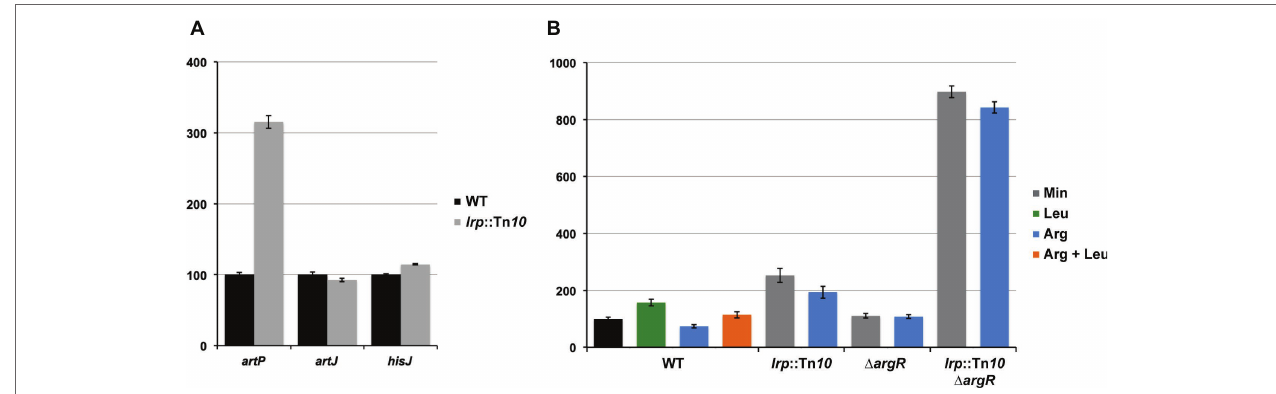
FIGURE 2 | Histogram presentation of β -galactosidase specific activities. Values are the means ± standard deviation of at least three biological replicates. (A) Specific activities measured in cell-free extracts of E. coli strain FW102 (WT) and its isogenic lrp ( lrp ::Tn 10 ) derivative bearing a single-copy lacZ reporter gene fusion under the control of the artP , artJ , or hisJ promoter/operator grown on minimal medium. 100% corresponds for each fusion construct to the activity measured in the wild type strain. (B) Specific activities of a single-copy lacZ reporter gene under the control of the artP promoter/operator measured in cell-free extracts of FW102 (WT) and its isogenic lrp ( lrp ::Tn 10 ), argR (∆ argR ), and double argR lrp ( lrp ::Tn 10 /∆ argR ) mutant derivatives. Cells were grown on minimal medium, supplemented with l -arginine, l -leucine, or both, as indicated. 100% corresponds to the value obtained for the wild type strain grown on minimal medium (black colored